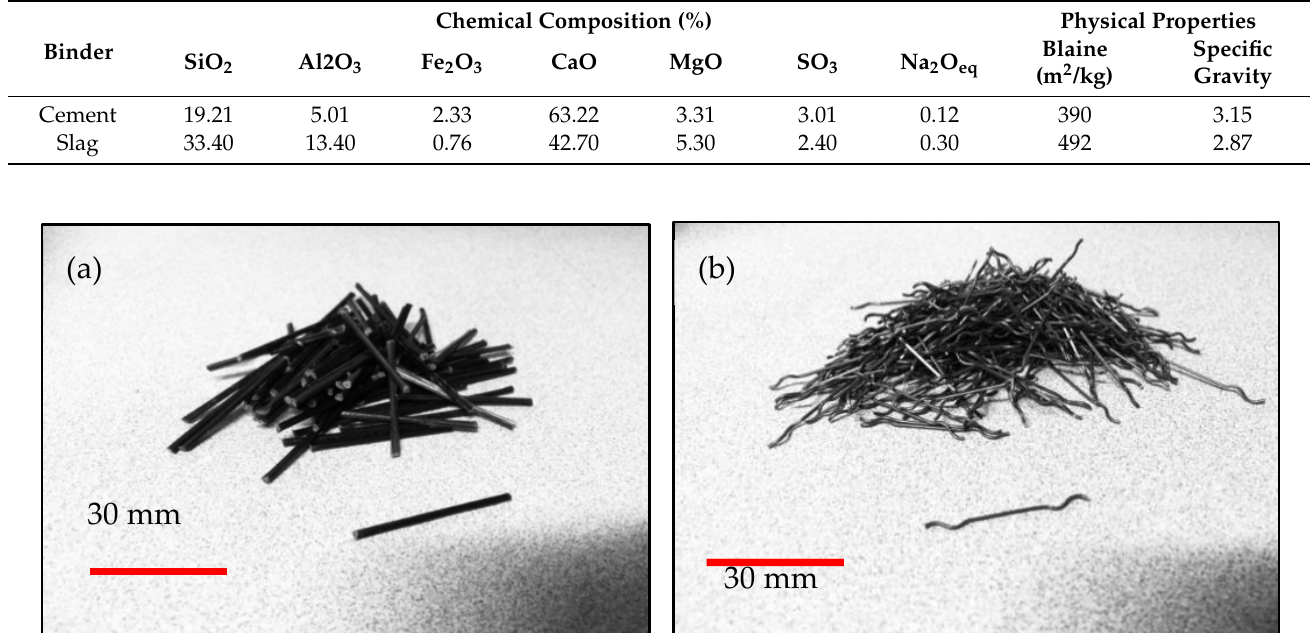
Table 1. Chemical and physical properties of GU cement and slag.